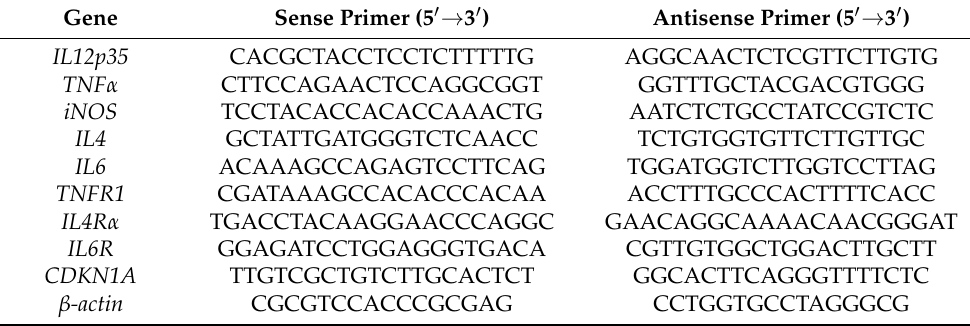
Table 2. Primer sequences used for the quantification of mouse genes.